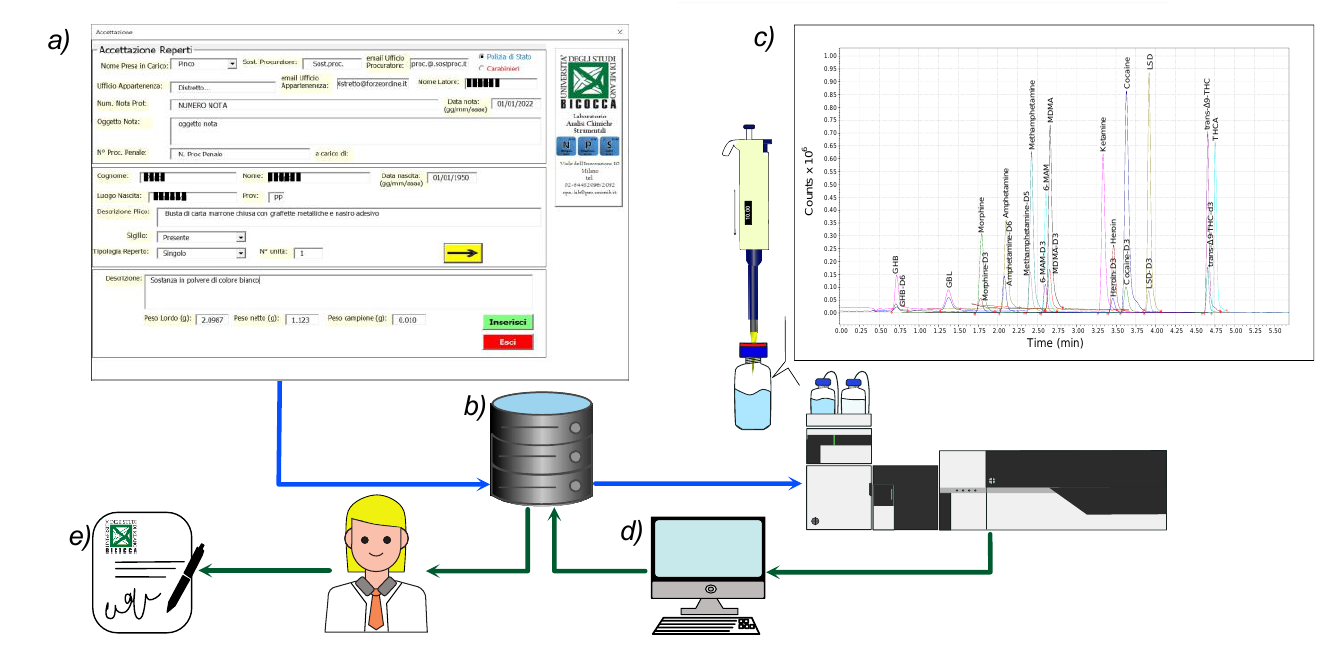
Figure 6. Schematic representation of the semi-automatic process for report generation, including data handling, analytical measurements, and results acquisition. ( a ) Screenshot of the software for seizure registration; ( b ) NPS Lab database with a two-way connection between registration software and UHPLC-MS/MS instrumentation software; ( c ) sample extraction and UHPLC-MS/MS determination; ( d ) data elaboration and final reporting; ( e ) report relayed to the law-enforcement authori- ties.